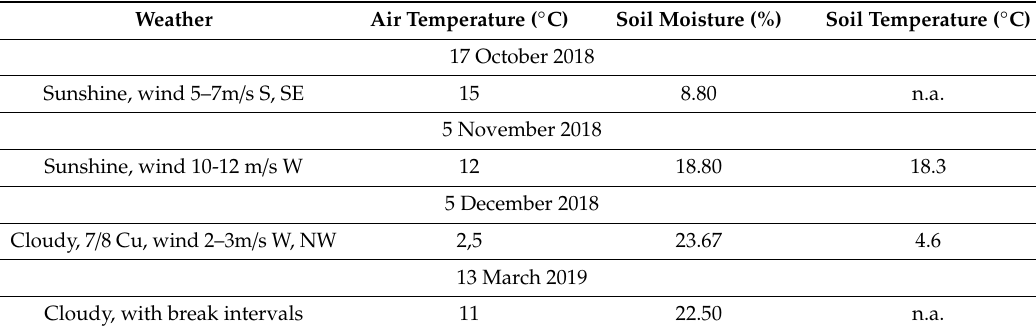
Table 1. Weather and soil conditions on the days of tests.